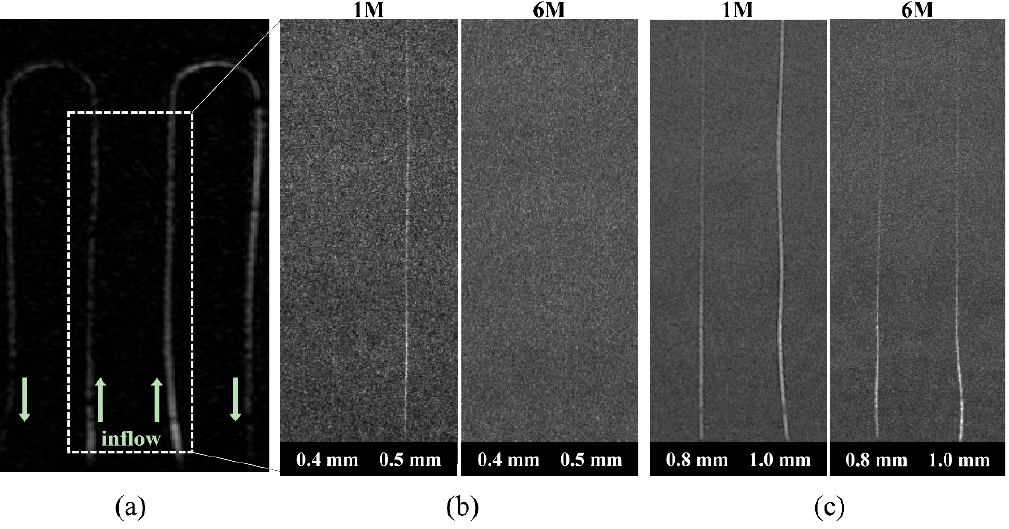
Figure 2. Three-dimensional high-resolution time-of-flight coronal maximum intensity projection (MIP) images for comparing diameters and lengths. ( a ) Coronal MIP image for reference. ( b ) MIP images of 1 m and 6 m tubes with 0.4 mm and 0.5 mm diameters. ( c ) MIP images of 1 m and 6 m tubes with 0.8 mm and 1.0 mm diameters. Table 3. Maximum signal intensities of tubes with various diameters and lengths in 3D High TOF sequence.